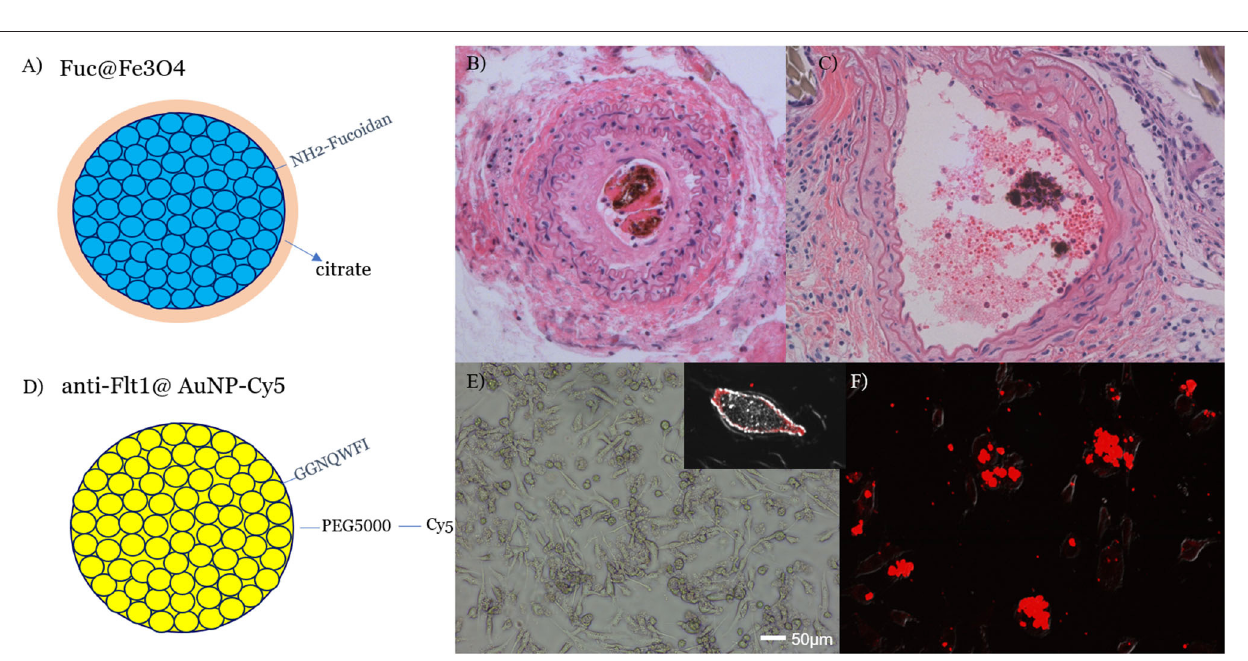
FIGURE 6 | A thrombolytic aminated fucoidan, targeting active thrombi, was conjugated to citrated iron oxide NPs (A) and delivered to a carotid artery-ligated and lipid-fed atheromatous mouse model with accompanied thrombosis (B) . Next, 4Gy proton TIBS showed flow recovery and partial removal of both the central thrombus and atheroma (C) . Dark materials in (B,C) were clusters of iron oxide NP that were taken up in thrombus. Central red blood cells in (C) indicated flow-recovery after treatment that was checked by a Doppler flow probe. VEGFR1(Flt1)-binding Flt1@AuNPs-Cy5 were prepared (D) and showed receptor binding in the membrane (E) and transcytosis in HRMECs (F) [21]. TIBS using either Fuc@Fe3O4 or Flt1@AuNPs will be applied to DME/RVO or AMD retinal disease models, respectively.